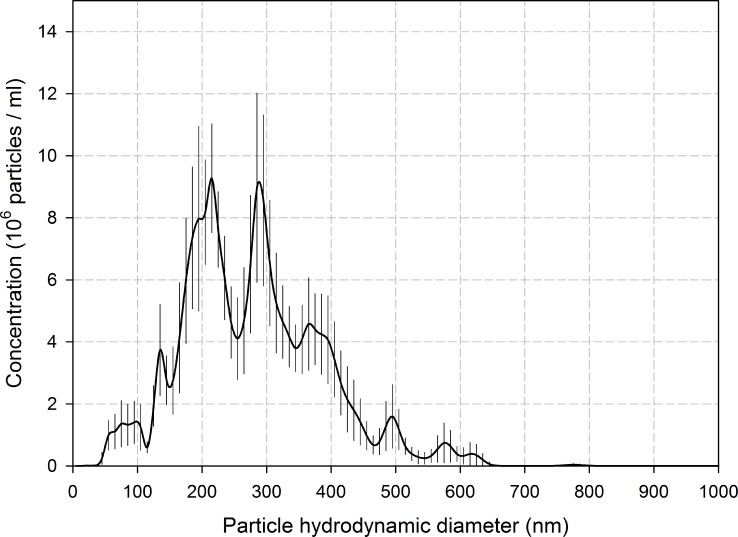
Nanoparticle spectrum of Arnica m. 1c. used as starting material.The line is the average of 10 replicate measurements and vertical bars indicate SD.